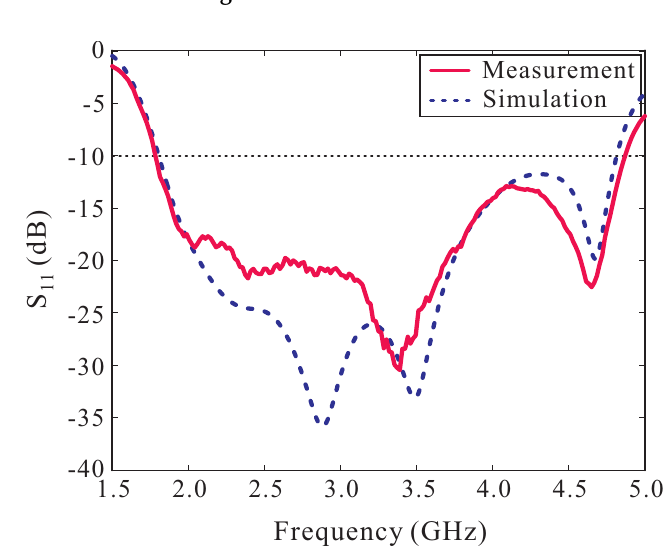
Figure 6. Fabricated antenna.